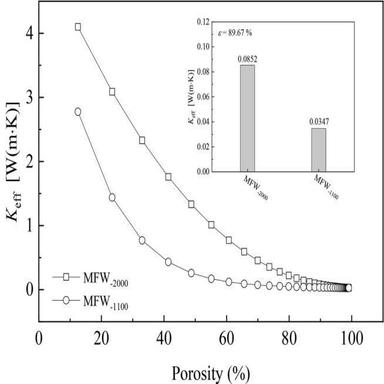
The relationship between porosity and thermal conductivity of MFW_2000 and MFW_1100 fractal model.